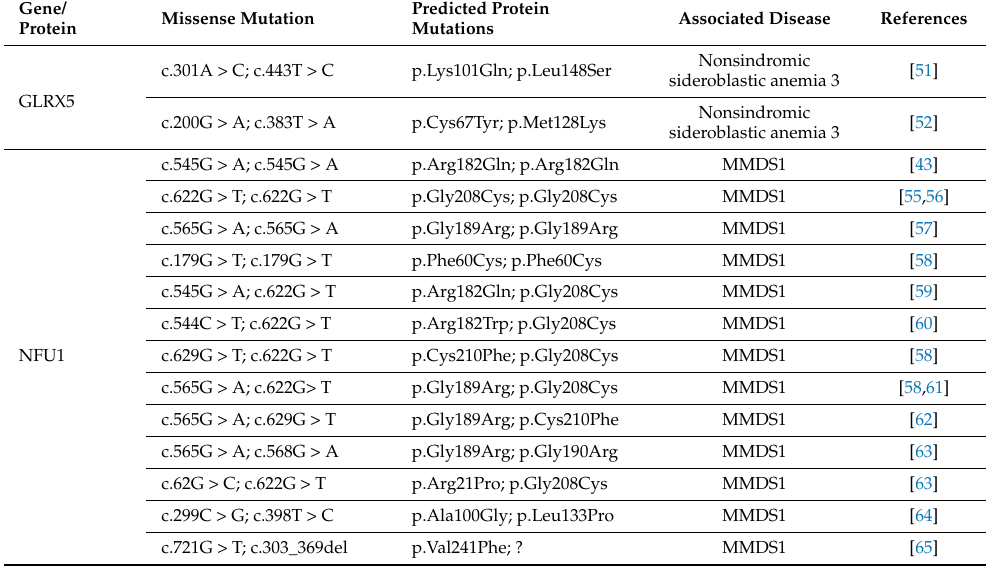
Figure 2. Pathogenic missense mutations mapped on the crystallographic structure of human GLRX5. ( A ) The backbone of the residues involved in pathogenic missense mutations of GLRX5 is shown in red on the ribbon structure of homodimeric [2Fe-2S] GLRX5 (PDB ID 2WUL). The sidechain of the conserved cluster coordinating Cys67 residue is shown in yellow. The iron and sulfur atoms of the [2Fe-2S] cluster are in red and yellow spheres, respectively; and glutathione (GS) ligand is shown in blue. ( B ) The electrostatic interaction established between the sidechain of Lys101 (in magenta) and the carboxylate group of the glutathione cluster ligand, shown in ball and stick mode, is shown as a dotted line. ( C ) The sidechains of the hydrophobic residues (in blue) interacting with the sidechain of Met128 (in magenta) are shown. Table 1. Missense mutations of the late-acting ISC components with the associated mitochondrial